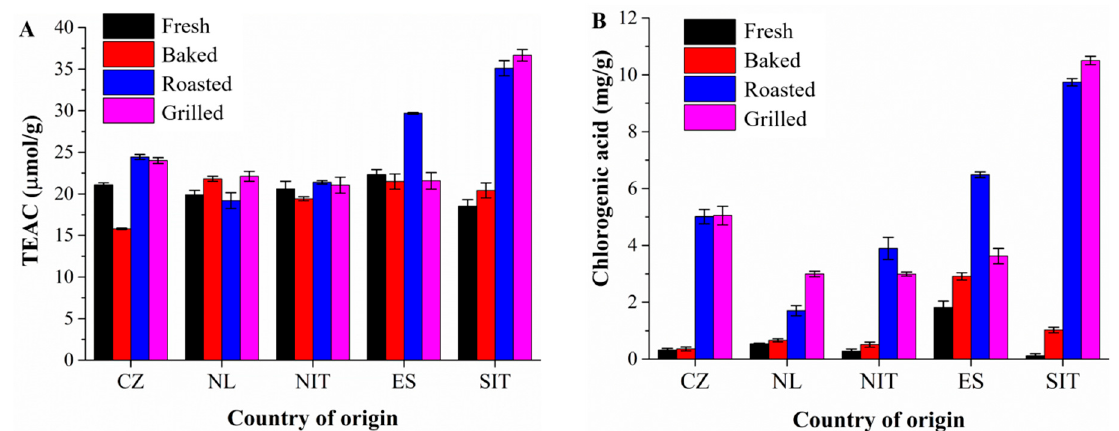
Figure 3. Trolox equivalent antioxidant capacity (TEAC) values (µmol/g) ( A ) and content of chlorogenic acid (mg/g, fresh weight (FW)) in eggplant samples measured by HPLC ( B ). CZ—Czech Republic, NL—the Netherlands, NIT—Northern Italy, ES—Spain, SIT—Southern Italy.